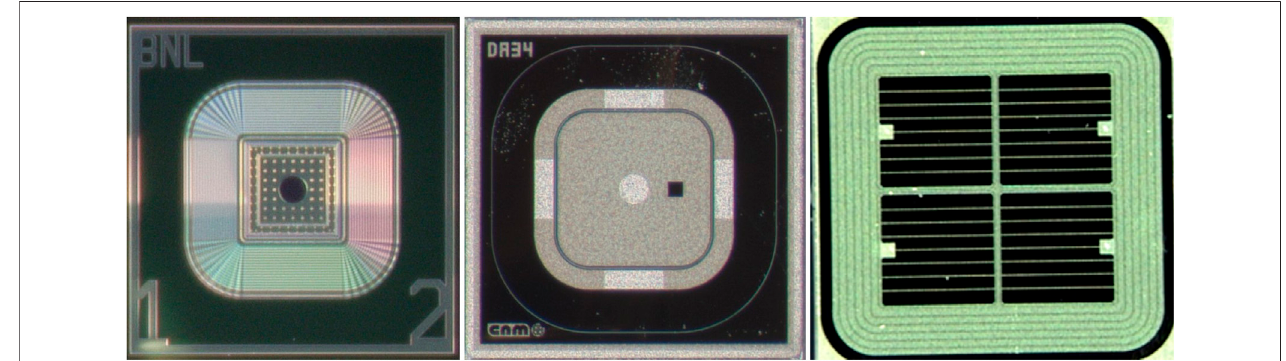
FIGURE 1 | Examples of LGADs produced by three different foundries: from left to right, BNL, CNM and IHEP-NDL.